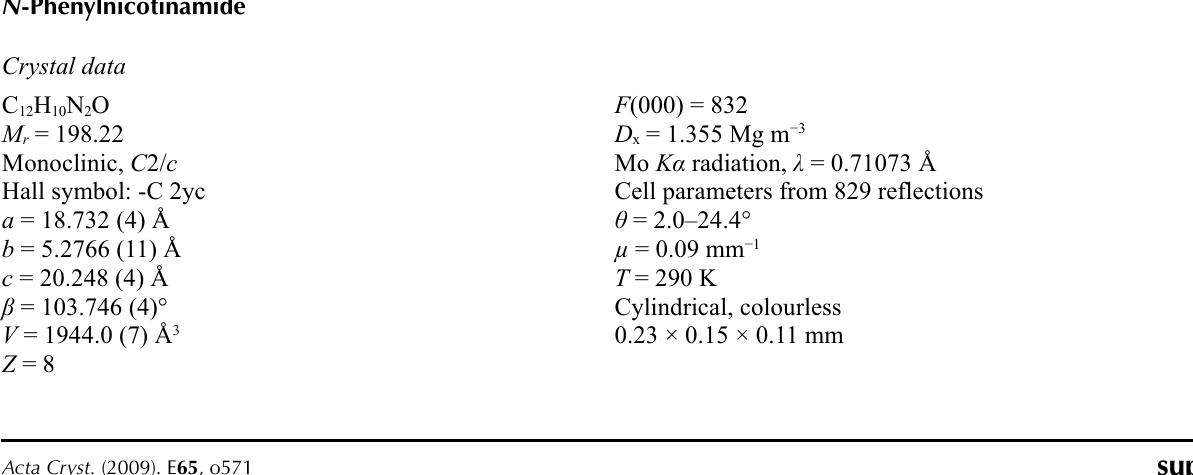
The crystal packing diagram of the title compound. The dotted lines indicate N—H···O intermolecular hydrogen bonds forming molecular chains along the b axis. All H atoms not involved in hydrogen bonds have been omitted for